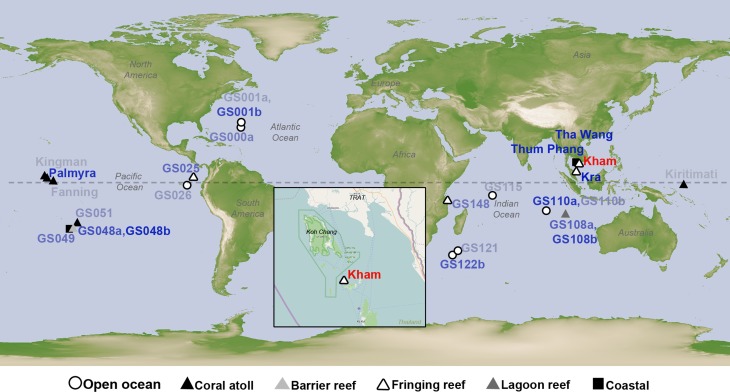
Satellite map showing the location of Kham island (red) relative to Kra, along with the other closely related marine microbial community sites, and all coral reef sites whose online microbial databases are available.Dotted line represents an equator line (0°latitude). The darker the blue font color, the closer the community similarity (based on Lennon and Yue & Clayton similarity indices) is to that of Kham. The map was from NASA Earth Observatory (public domain) (http://earthobservatory.nasa.gov/), with the inset Kham map from OpenStreetMap (http://www.openstreetmap.org/), retrieved on 13 December 2016.